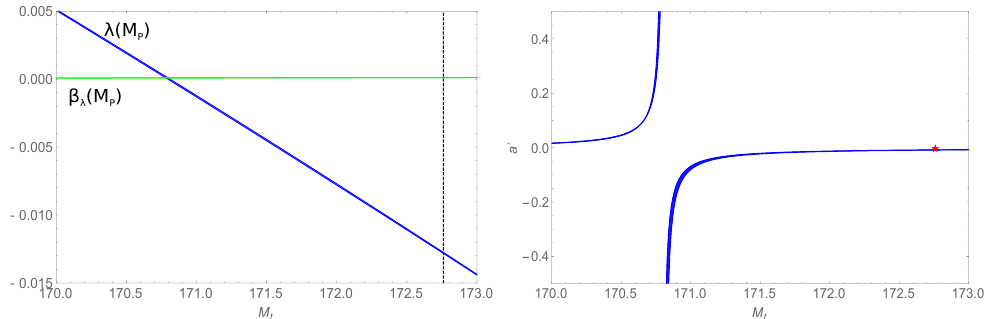
Figure 5 . λ ( M P ) , β λ ( M P ) vs M t (left) and a 0 vs M t (right). The thickness in each curve reflects the variation in the non-minimal coupling ξ , defined at Planck scale, 100 ≤ ξ ( M P ) ≤ 5000 . Also, the observed value of the top quark pole mass is indicated by the black dashed line (left) and the red star